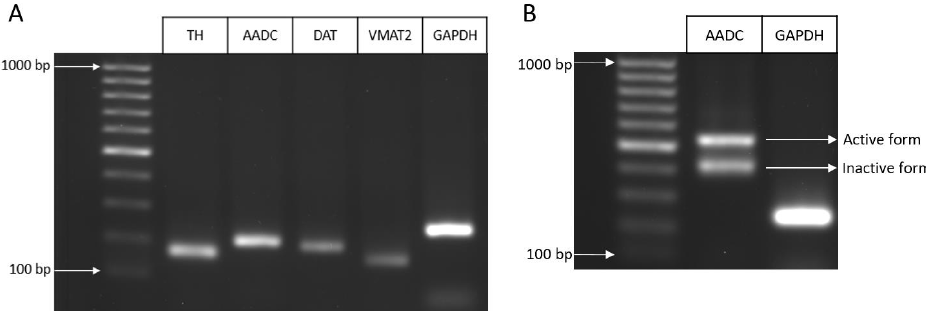
Figure 2. ( A ): expression of dopaminergic phenotype protein genes: tyrosine hydroxylase (TH), dopamine transporter (DAT), aromatic L-amino acid decarboxylase (AADC), vesicular monoamine transporter 2 (VMAT2), as well as the housekeeping gene glyceraldehyde-3-phosphate dehydrogenase (GAPDH); ( B ): agarose phoresis for the AADC mRNA region between exons 2 and 5. Several forms of AADC are visible. The lower band corresponds to the gene for the enzymatically inactive form of AADC, which lacks exon 3, while the upper band corresponds to the gene for the enzymatically active form of AADC.